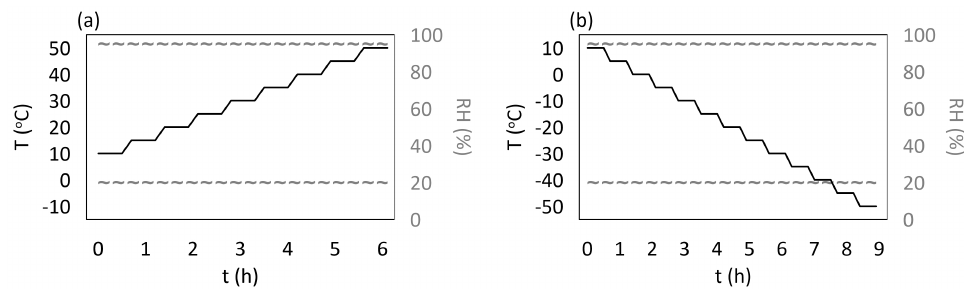
Figure 3. The thermal tests programs for temperatures: ( a ) elevated, ( b ) sub-zero.